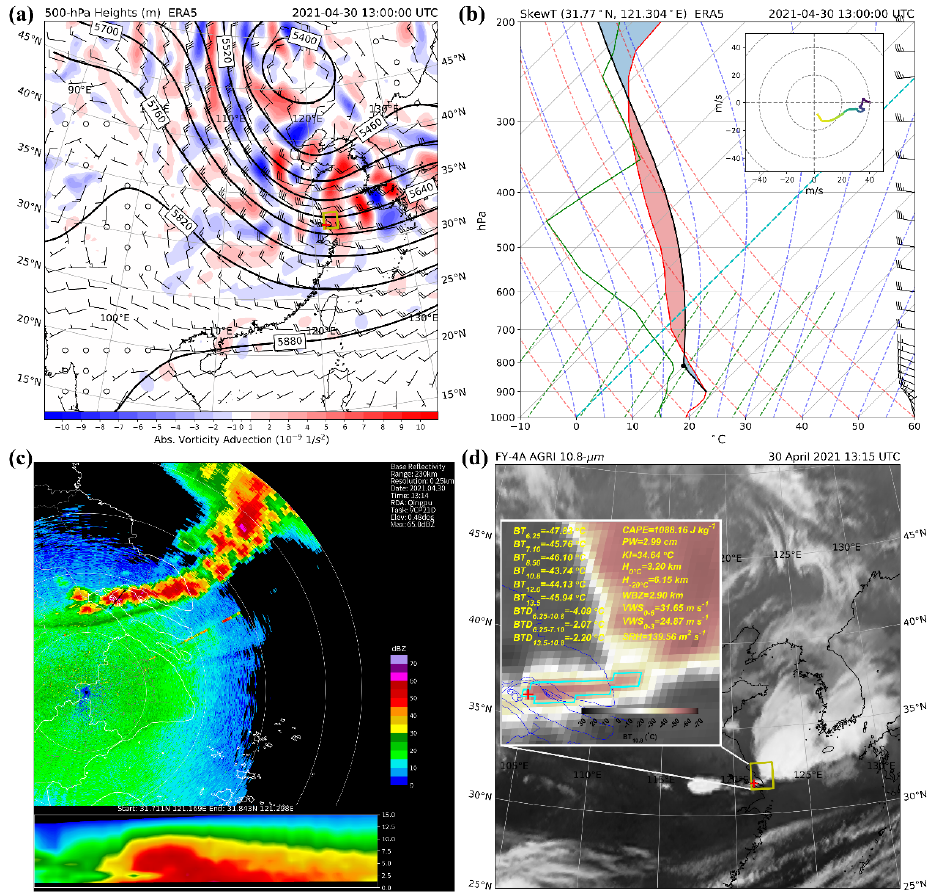
Figure 8. Hail event (red cross) occurred at about 13:14 (UTC) on 30 April 2021, in Chongming District, Shanghai, China: ( a ) 500 hPa weather map; ( b ) SkewT near hail event; ( c ) radar reflectivity; ( d ) FY-4A 10.8 μ m image, the inset image shows the hailstorm sample (Figure 3a) that was to calculate MHD. The yellow rectangles in ( a , d ) represent the same geographic range.